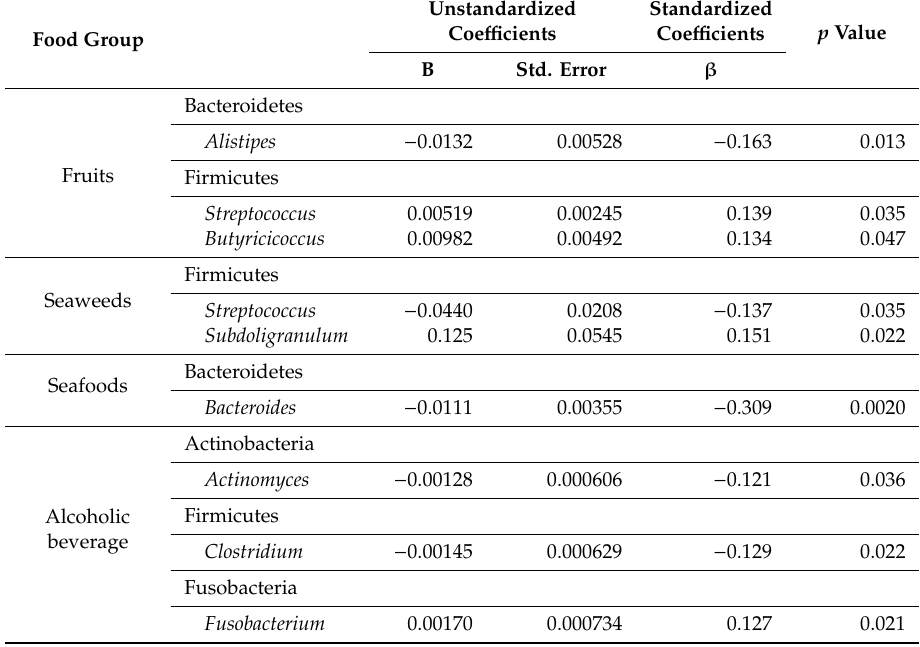
Table 4. Significant associations between food groups associated with β -diversity and numbers of gut bacteria at the genus